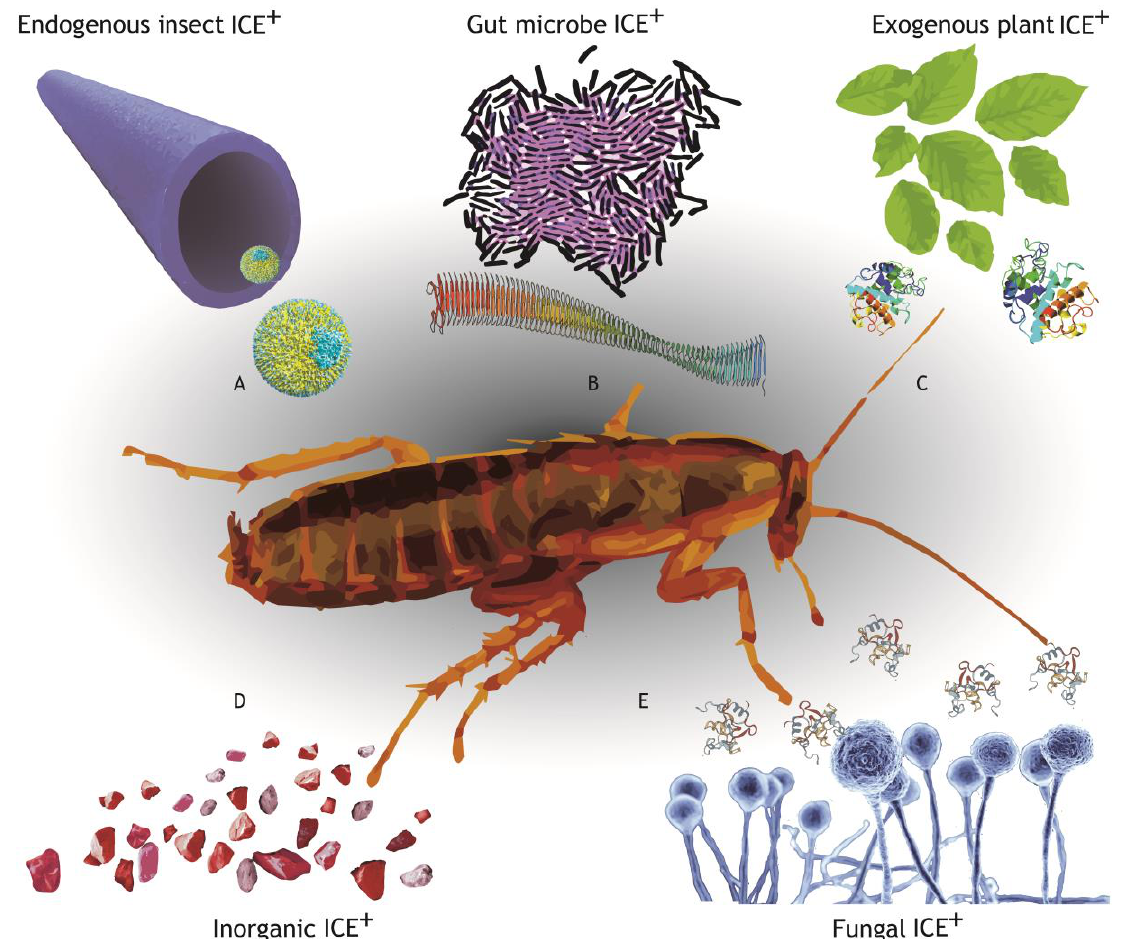
Figure 3. Insects that are freeze tolerant usually have relatively high temperatures of intercellular water crystallization facilitated by ice-nucleating agents (ICE + ). There are many possible sources of ice+ agents in the environment and within the insect, of different sizes, stability, and efficiency. For example: ( A ) manufactured by the insect, e.g., lipoproteins in Tipula trivittata [46], ( B ) derived from microbes, e.g., large proteins from Pseudomonas borealis [47], ( C ) created by plants, e.g., class II chitinase [48], ( D ) environmental particles, e.g., kaolin-iron oxide composites [49], and ( E ) manufactured by fungi, e.g., fungal hydrophobins [50].